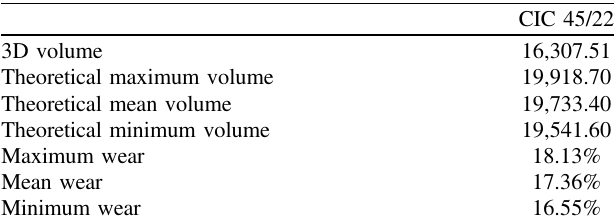
Figure 10. Shifting of the centres of rotation (yellow dot: cup ’ s centre of rotation, black dot: head ’ s centre of rotation, blue dot: liner ’ s centre of rotation). Table 1. Wear measurements of the liner CIC 45/22